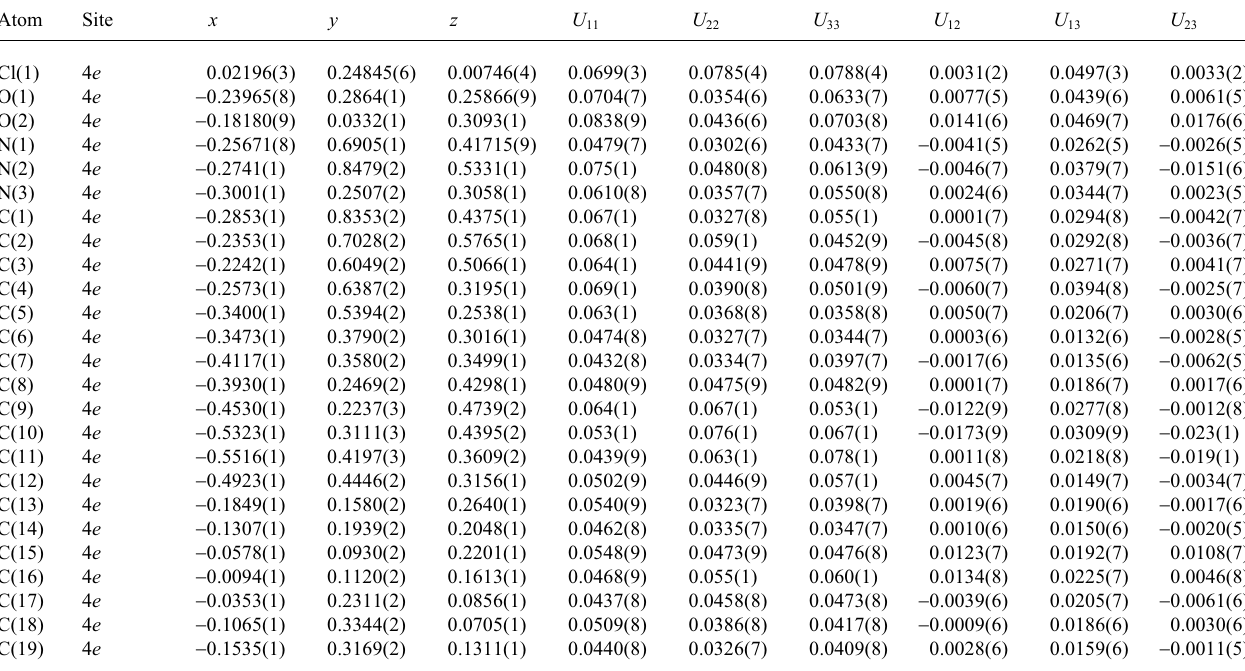
Table 3. Atomic coordinates and displacement parameters (in Å 2 )